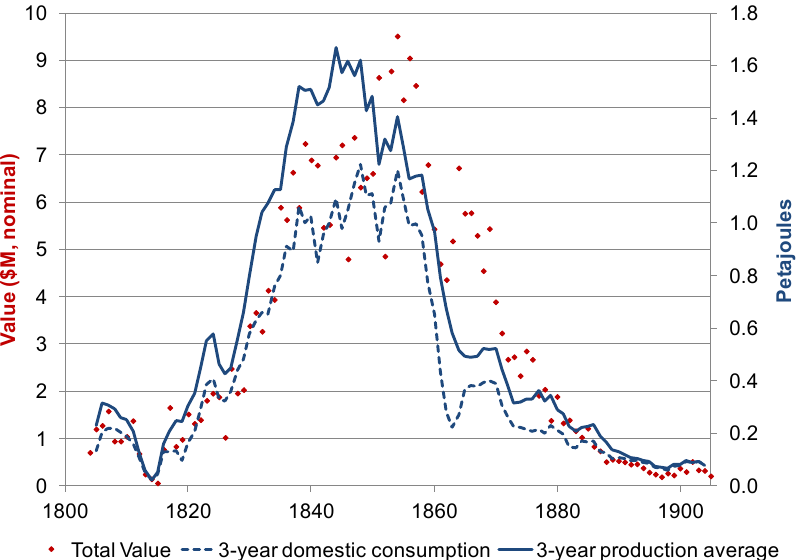
Figure 5. Whale oil production, consumption, and total value. Sources: [36–38].